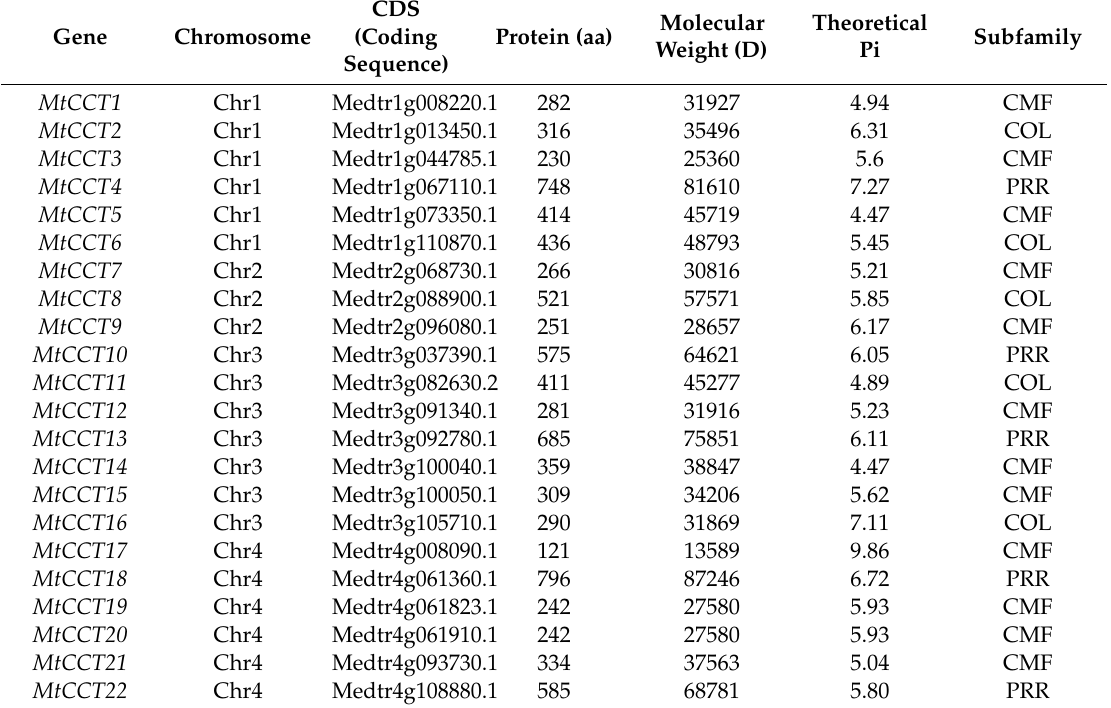
Table 1. Properties and locations of the predicted CCT (CO, COL and TOC1) proteins in M. truncatula . Gene Chromosome